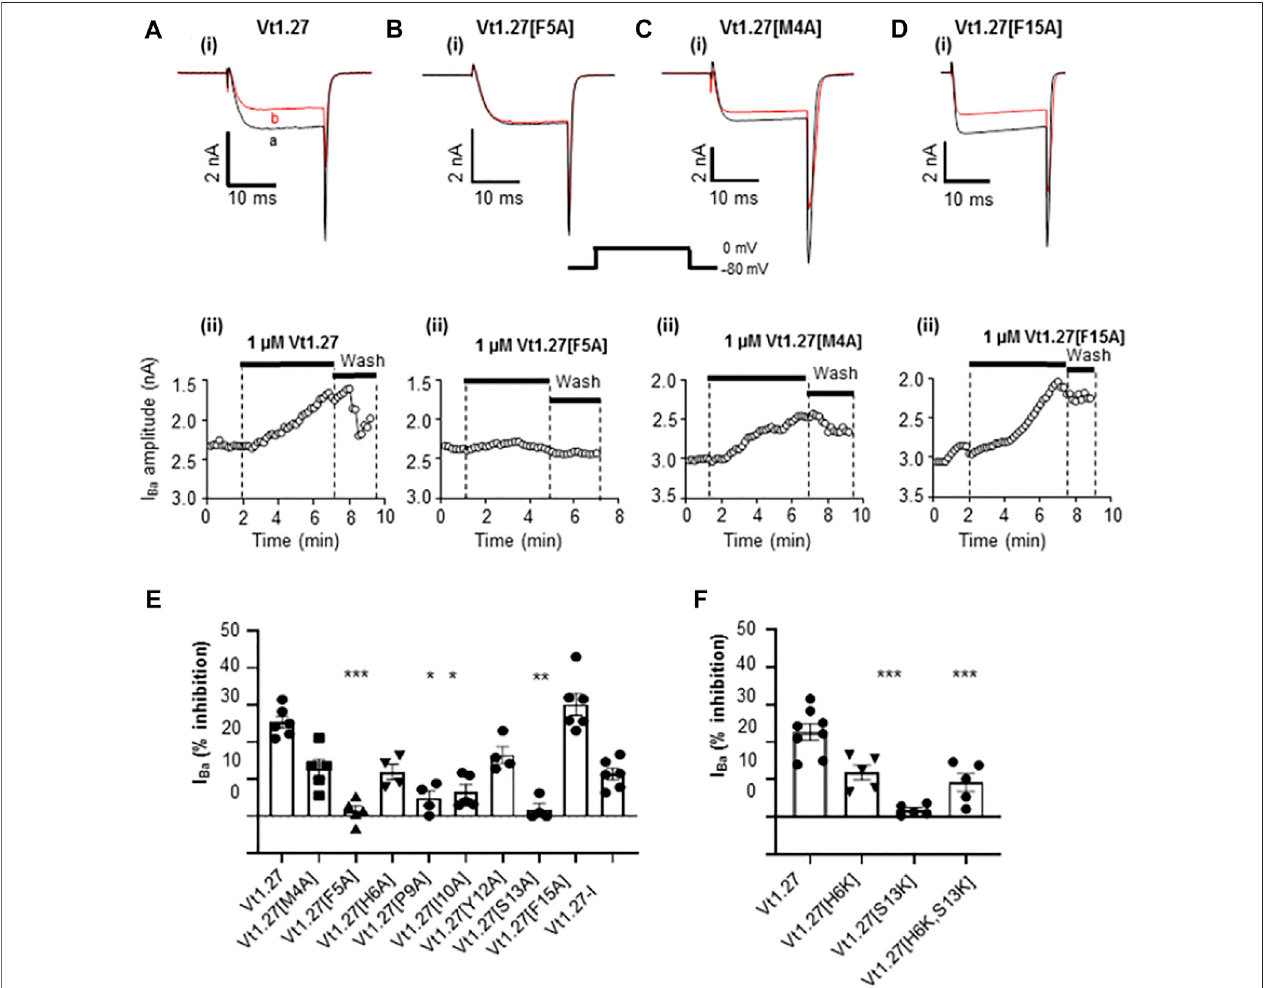
FIGURE 6 | Effects of Vt1.27 alanine mutants on Ca V 2.2 channels expressed in HEK293T cells. (A-Di) Representative depolarization-activated Ba 2+ currents (I Ba ) elicited from a holding potential of − 80 mV to a test potential of 0 mV (20 ms duration; 0.2 Hz) from HEK293 cells expressing Ca V 2.2 in the absence (control, a) and presence of1 µM Vt1.27 analogues (B) . (A – Dii) Correspondingtime plots ofI Ba amplitude before, during, and uponwashout ofpeptide. (E,F) Bar graph showing mean